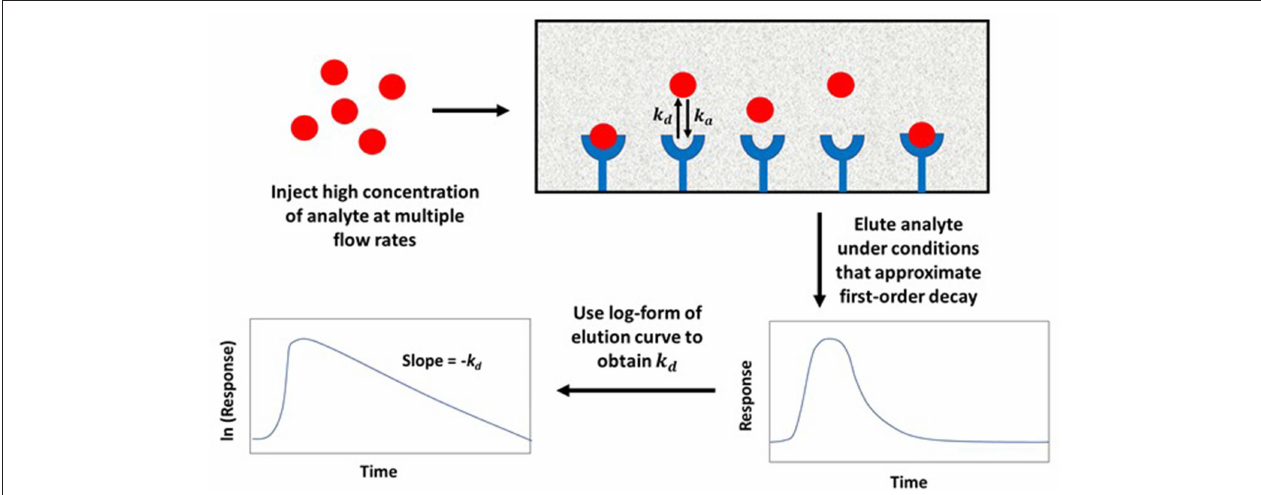
FIGURE 6 | General scheme used for studying analyte interactions with an immobilized binding agent by the non-competitive peak decay method. Terms: k d , dissociation rate constant; k a , association rate constant.